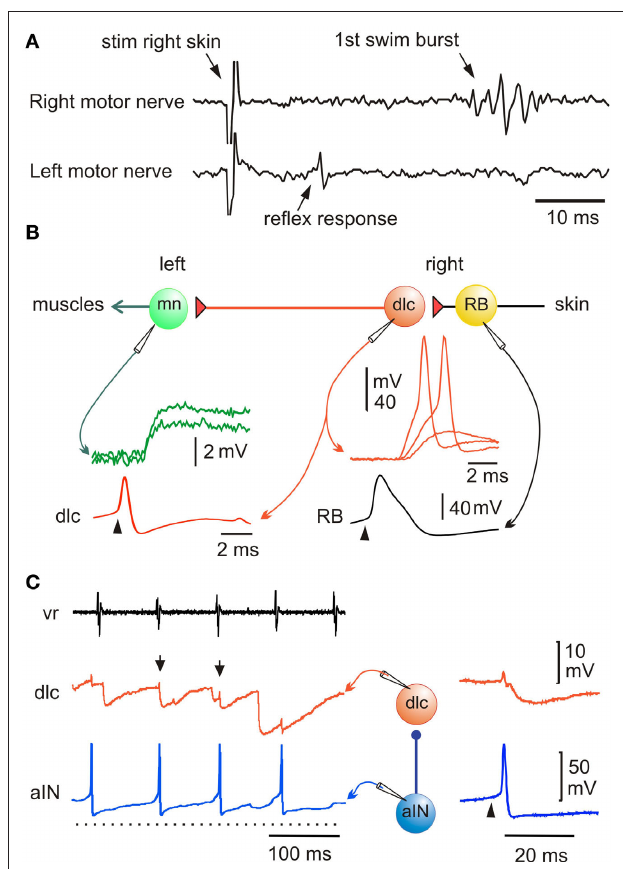
Figure  | Pathway for a simple flexion reflex. (A) motor nerve recordings show that a skin stimulus on the right produces a short latency reflex response on the left. (B) Diagram of reflex pathway where sensory RB neurons excite dlc interneurons and they excite motoneurons on the opposite side. Paired recordings show that current to the RB (arrowhead) leads to an action potential and after delay, to a large EPSP or action potential in the dlc interneuron; an action potential in the dlc leads to a small EPSP in the motoneuron. (based on Li et al., 2003b). (C) A paired recording shows an aIN active during swimming (monitored by ventral root electrode, vr) and that some aIN spikes lead to IPSPs in a dlc interneuron (small arrows). If current is injected to make the aIN fire (right panel; arrowhead) an IPSP is seen in the dlc. (based on Li et al.,